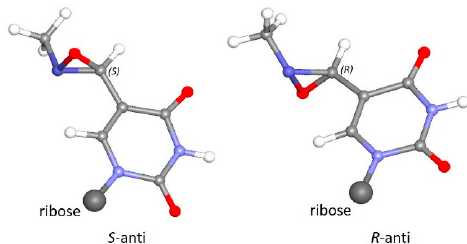
Figure 8. Geometry optimization of oxaziridine derivatives 3 and 4.